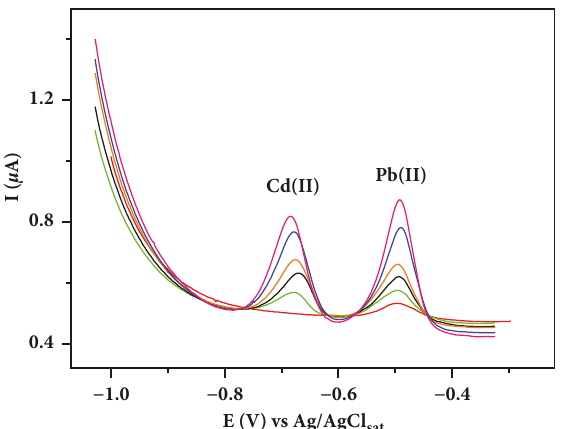
Figure 6: Differential pulse anodic stripping voltammograms for 1.00 mL wastewatersample in 9.00 mL acetate buffer solution (pH 4.5) with increasing Cd(II) and Pb(II) concentrations (48.3 to 233 𝜇 g L −1 ) using BiFE.